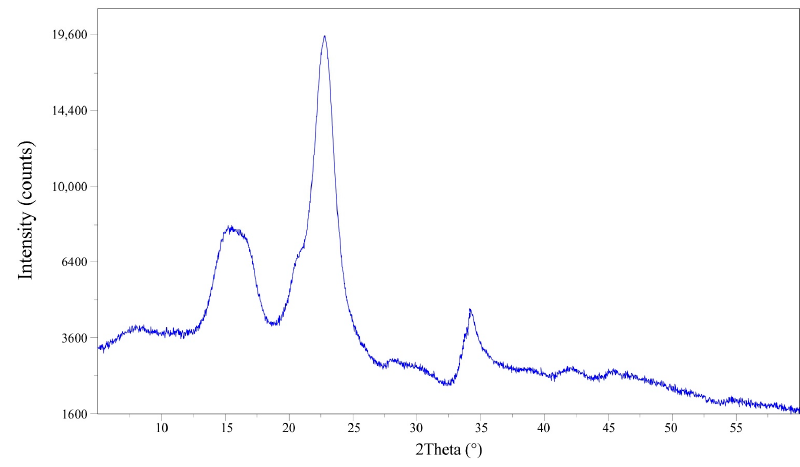
Figure 4. Diffractogram of nanocellulose isolated from banana pseudo-stems.